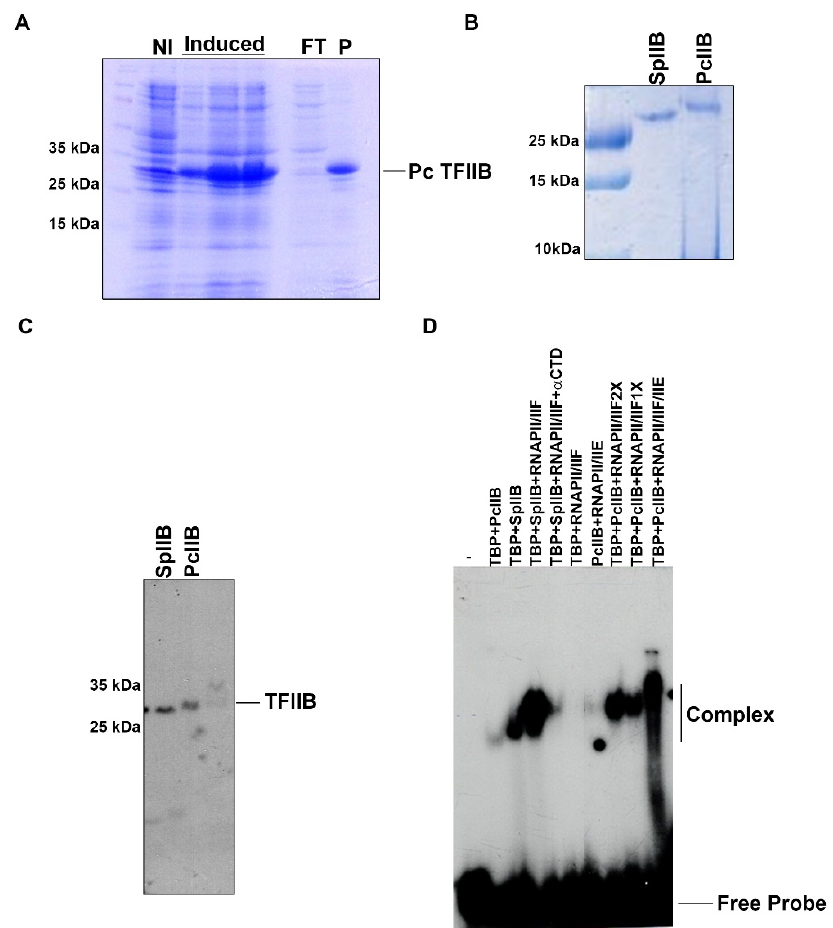
Figure 3. Purification of recombinant P. carinii TFIIB and complex formation on a TATA box promoter. ( A ) Induction and purification of PcIIB. A pET-15b construct carrying on the PcIIB cDNA was transformed in E. coli BL21(DE3) and induced with IPTG to produce the recombinant PcIIB. The transformed E. coli cells were grown at OD 600 of 0.6 and induced with IPTG for 1, 2 and 4 h. The non-induced (NI) and induced cells were broken by SDS sample buffer and analyzed for the induced polypeptide in a 10% SDS-PAGE gel followed by Coomassie Blue R-250 staining. Note that the NI culture produces low amounts of the P. carinii TFIIB in the absence of IPTG. This is due to traces of inducers in the LB media. The recombinant protein was insoluble, and it was purified from the pellets as described in Materials and Methods. Lane FT is the proteins that do not bind to the NTA-Ni-Agarose column and P represents the bound proteins to the column. ( B ) A 10% SDS-PAGE gel to compare and analyze S. pombe TFIIB (SpIIB) and P. carinii TFIIB (PcIIB). ( C ) Western blot to analyze recombinant TFIIB. The samples were separated on a 10% SDS-PAGE and transferred to PDVF membranes and probed with anti-His tag monoclonal antibodies. ( D ) Complex formation of PcIIB and fission yeast TBP, TFIIF, RNAPII and TFIIE on the Ad-MLP TATA box. An EMSA was performed using different combinations of GTFs and RNAPII as indicated at the top of the figure. The amounts of PcIIB, TBP, SpIIB and TFIIE were 20 ng of each factor in the reaction. TFIIF1X represents 20 ng and TFIIF2X represents 40 ng of the added factor. The used amount of RNAPII was 100